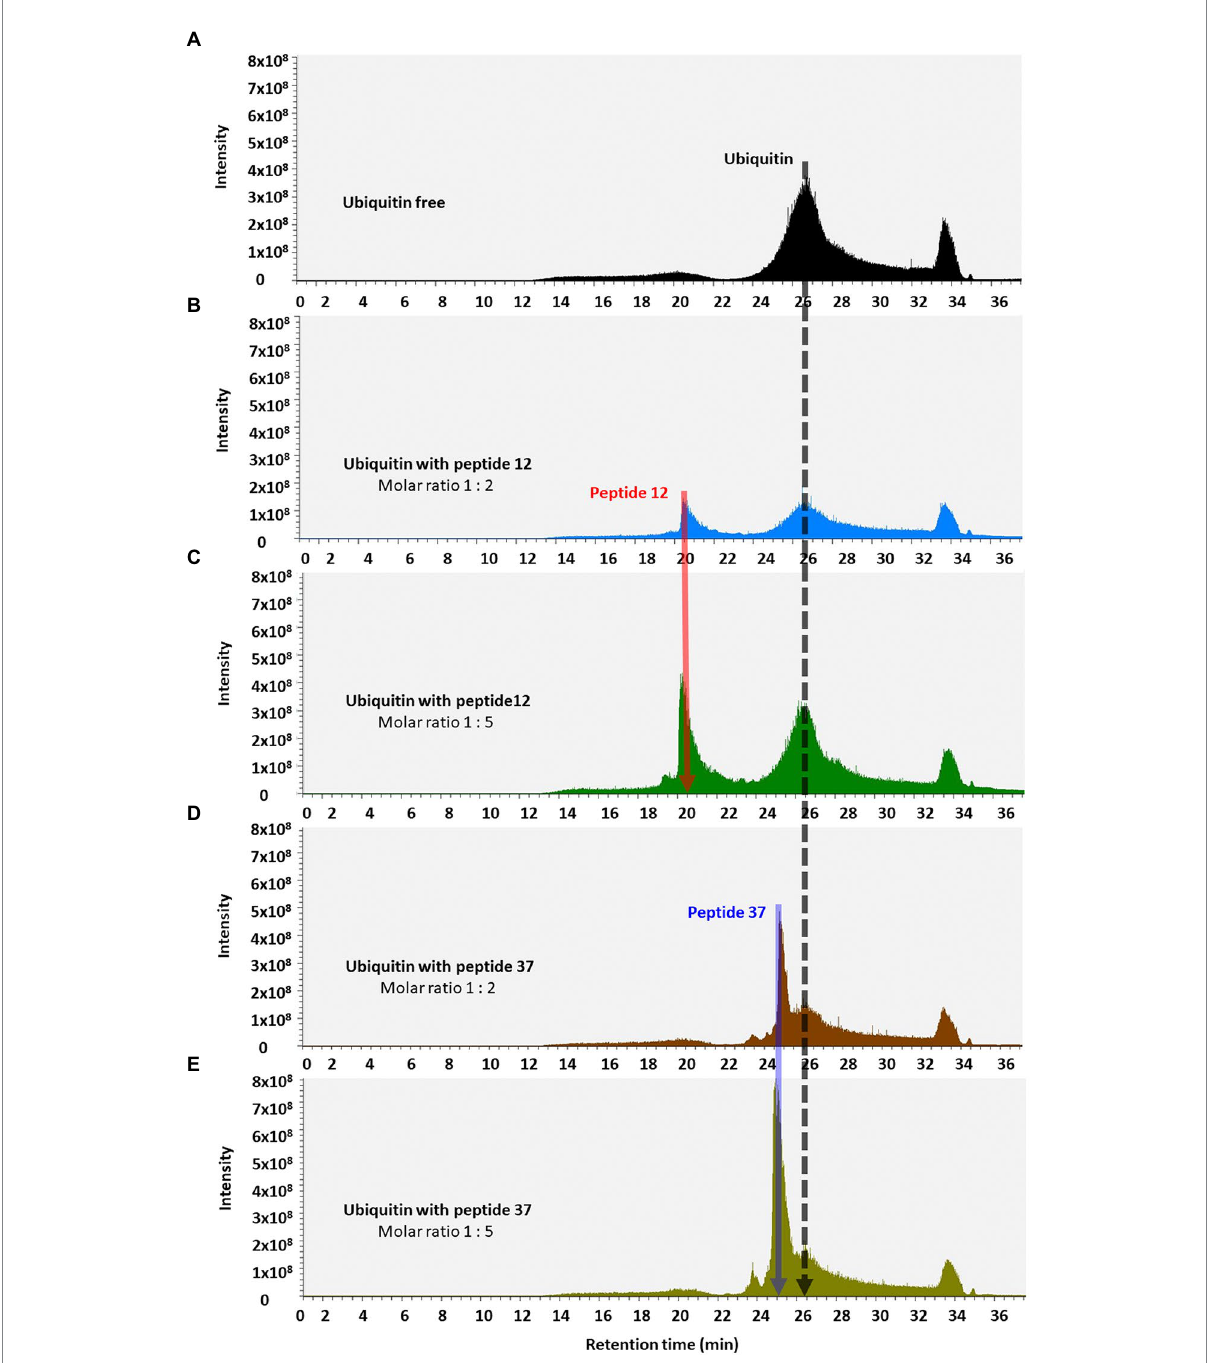
FIGURE 7 Total ion chromatograms of ubiquitin-peptide complexes. Ubiquitin was incubated alone (A) or with the indicated peptides (B–E) , diluted in D 2 O with 1% DMSO, and separated on a reverse phase C18 column according to the approach described in Methods. Total ion chromatogram was plotted as the relative abundance of the signal observed at a chosen m/z value as a function of RT. Material eluted at highlighted position and RT were confirmed by MS/MS analysis (Orbitrap Elite mass spectrometer) as the peptide-12 (red line, RT 20.25–22.00 min); the peptide-37 (blue line, RT 25.28–25.67 min), and ubiquitin (black line, RT 24.45–28.70